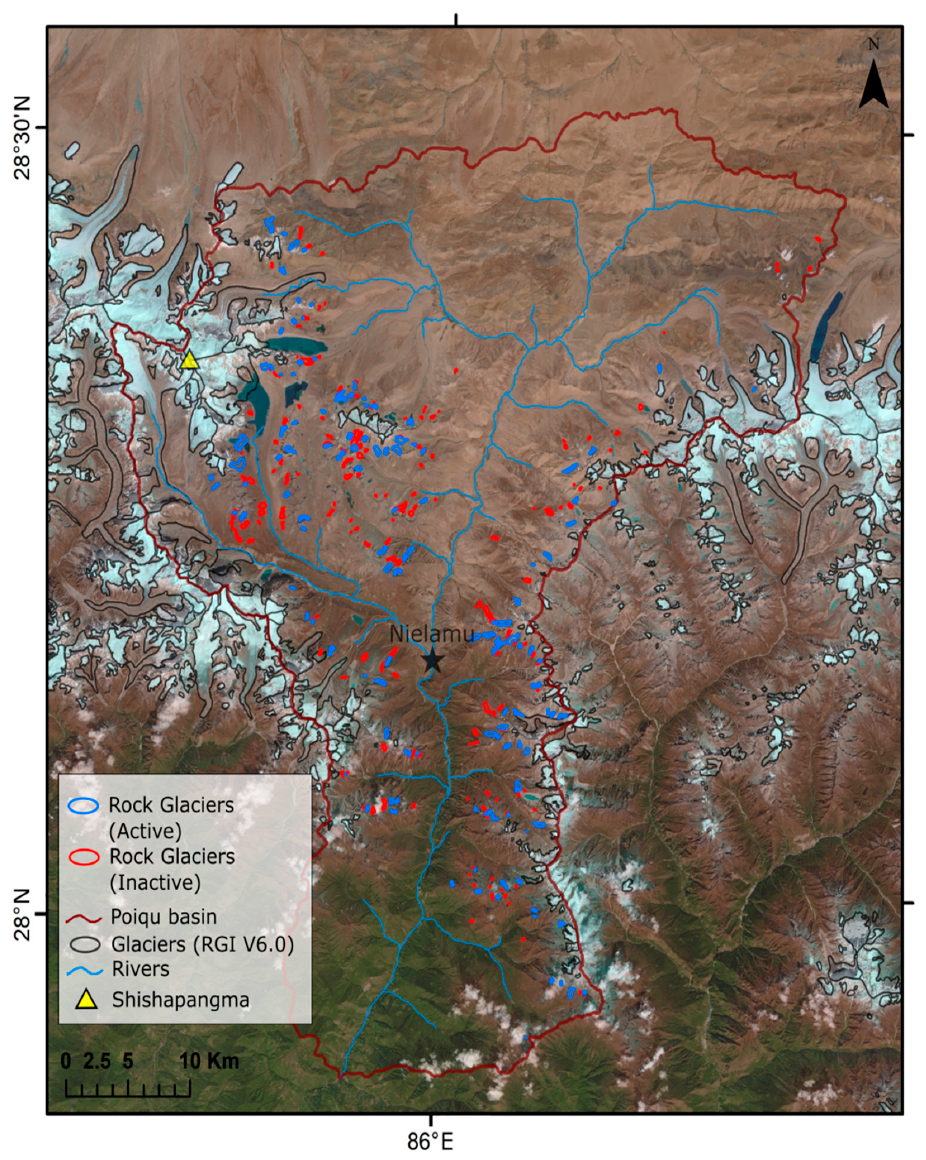
Figure 6. Rock glacier inventory of the Poiqu basin, background image: True colour composite of a Sentinel-2 image, acquired 12 September 2016 (data source: Rastner et al. (in rev. [51]).